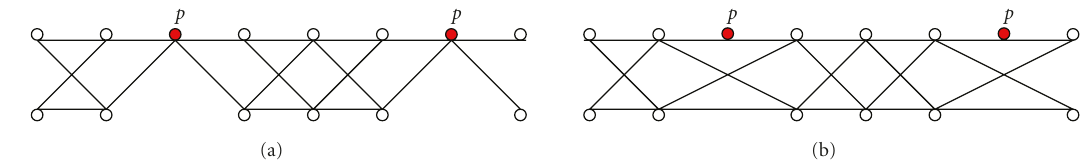
Figure 8: Trellis diagram of binary di ff erential PSK with pilot insertion. (a) Pilot symbols periodically terminate the trellis. (b) Pilot symbols are separated from the trellis structure.